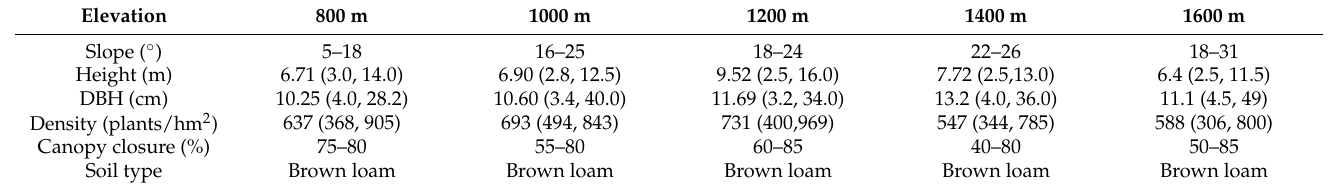
Note: DBH, diameter at breast